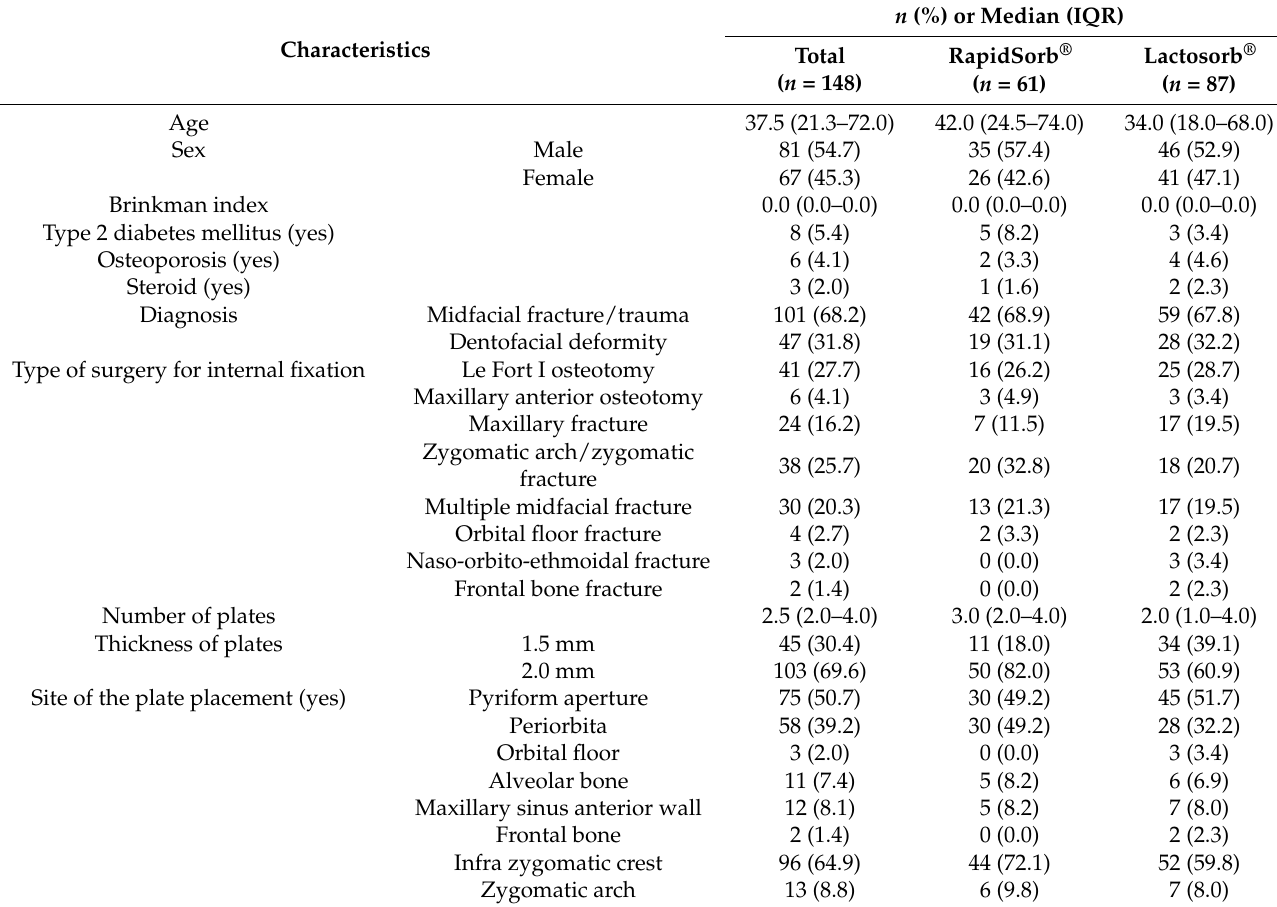
Table 1. Demographic characteristics of participants ( n =